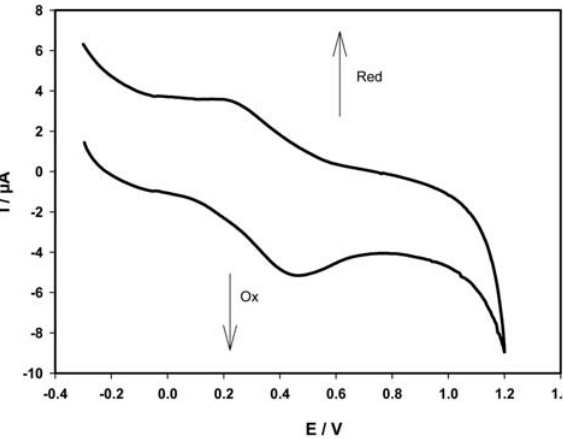
Figure 2: Cyclic voltammogram of PYCPE in BR buffer (pH 2.0). Scan rate of 100